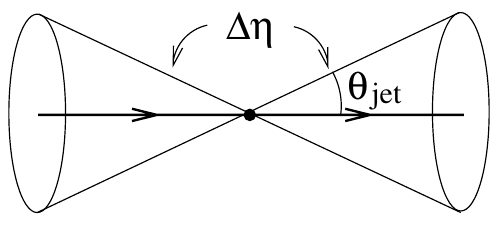
Figure 1 . The rapidity slice where the measurement is